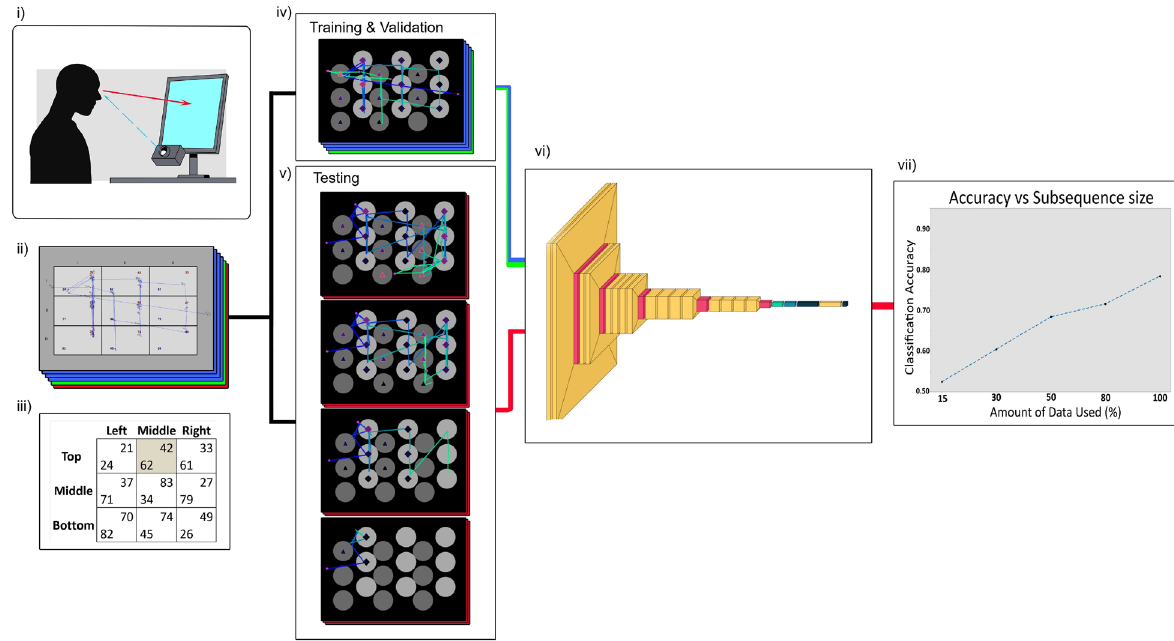
Figure 1. Overview of approach: ( i ) In this eye-tracking study, the gaze behavior of the participants was recorded as they played games presented on a computer screen, using a tower mount eye-link with a sample rate of 1000 HZ ( ii ) An example of how we presented the games during the eye-tracking experiment. The payoffs of the Row player are coloured in blue and the payoffs of the Column player are in red. The payoffs are separated by the maximum distance allowing for the clearest possible distinction between ocular events that happened in different areas of interest. In this example, the raw gaze recording of a single participant is displayed on the game board in order to highlight the difference between the raw gaze data and the scanapath images used as model input ( iii ) An example of how a two-player strategic interaction can be represented using games presented in normal-form. The Row player (the human participant in our experimental task) can choose between the actions “Top”, “Middle” and “Bottom”. The Column player (the algorithm in our experimental task) can choose between the actions “Left”, “Middle”, and “Right”. The action selected by the Row player affects the payoff received by the Column player and vice-versa. The game’s outcome is the cell given by the intersection between the action selected by the Row player and the action selected by the Column player. The Row player receives the payoff located in the bottom-left part of the cell, and the Column player gets the payoff located in the upper-right part. The equilibrium of the game is highlighted in gray. ( iv ) Before performing any analysis, we split the data into three sets of participants. We allocated approximately 70% of the participants for training the model, 20% for validation of the results, and kept 10% of the participants as a hold-out test set. ( v ) Using the hold-out test, we consider a series of independent model tests where we create sets of shortened scanpaths based on criteria such as percentage, or only allowing scanpaths to be created within a certain amount of time (e.g., 2 s or 5 s). ( vi ) We pass these sets of scanpaths through our fully trained model, testing its predictive ability. ( vii ) A